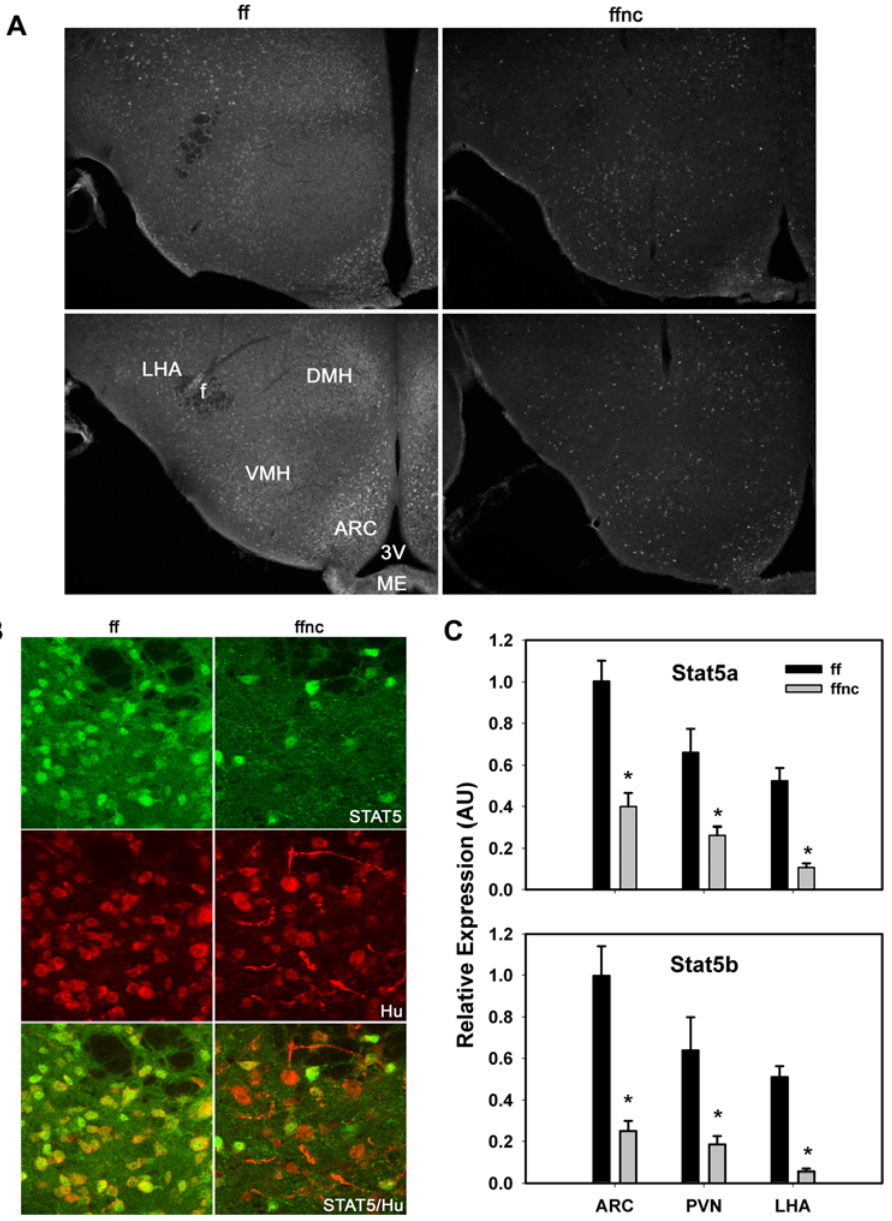
Figure 1. Reduced STAT5 expression in hypothalamic neurons in Stat5 fl/fl;Nestin-Cre male mice. (A) Immunohistochemical analyses with a STAT5 antibodies were performed on hypothalamic tissues from Stat5 fl/fl control (ff, left panels) and Stat5 fl/fl; Nestin-Cre (ffnc, right panels) mice. Note the prominent expression of STAT5 isoforms in discrete neurons and the dramatic reduction in STAT5-positive cells in ffnc mice. Upper panels show hypothalamic sections rostral to those shown in lower panels. 3V=third cerebral ventricle, ME=median eminence, f=fornix; all other abbreviations as defined in the text. (B) Immunostaining for STAT5 (green, top), the neural marker, Hu (red, middle) and merged images (bottom) in the LHA ff and ffnc animals. This demonstrates the co-localization/expression of STAT5 in neurons of ff animals and the absence of STAT5 from many Hu-positive neurons in ffnc mice. (C) Total RNA from microdissected hypothalamic subregions of ff and ffnc mice was subjected to semi-quantitative real-time PCR for STAT5A and STAT5B mRNA expression, confirming the reduction in the expression of both STAT5 isoforms in each